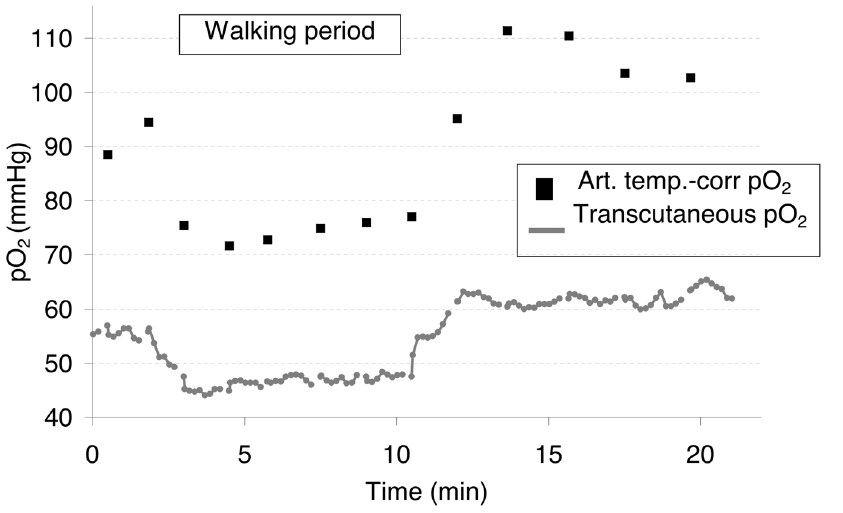
Figure 4. Simultaneous recording of chest transcutaneous and arterial oxygen pressure. Chest transcutaneous oxygen pressure (Transcutaneous pO 2 ) and arterial pressure corrected for temperature changes (Art. temp.-corr. pO 2 ). The dark square is the walking period.